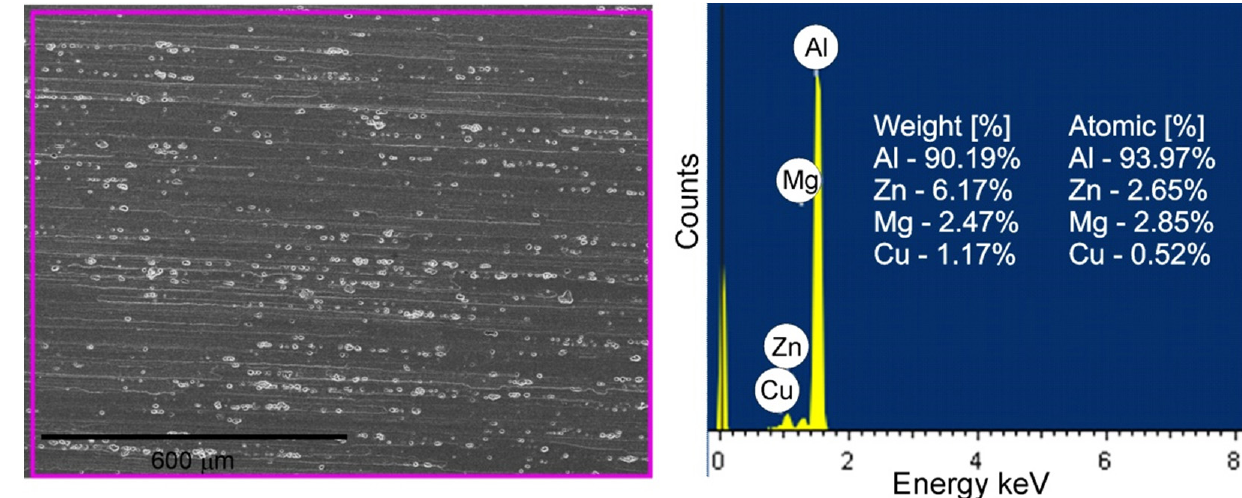
Figure 8. EDS of BM results.